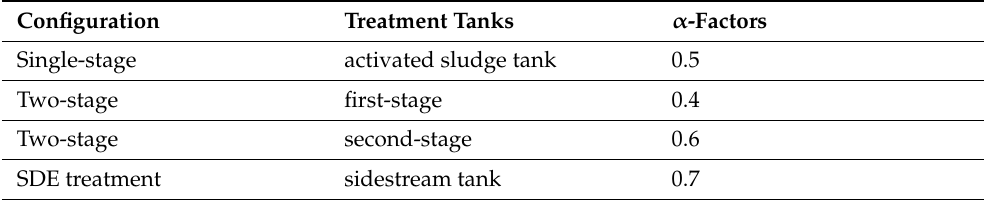
Table 3. α -values considered for different treatment